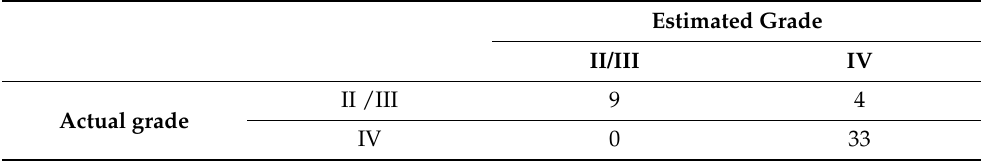
Figure 5. Example of a case with a low similarity index. ( a ) Input image, ( b ) ground-truth image, ( c ) output image, and DSC values calculated in the volume data. Table 1. Confusion matrix of the grading result.